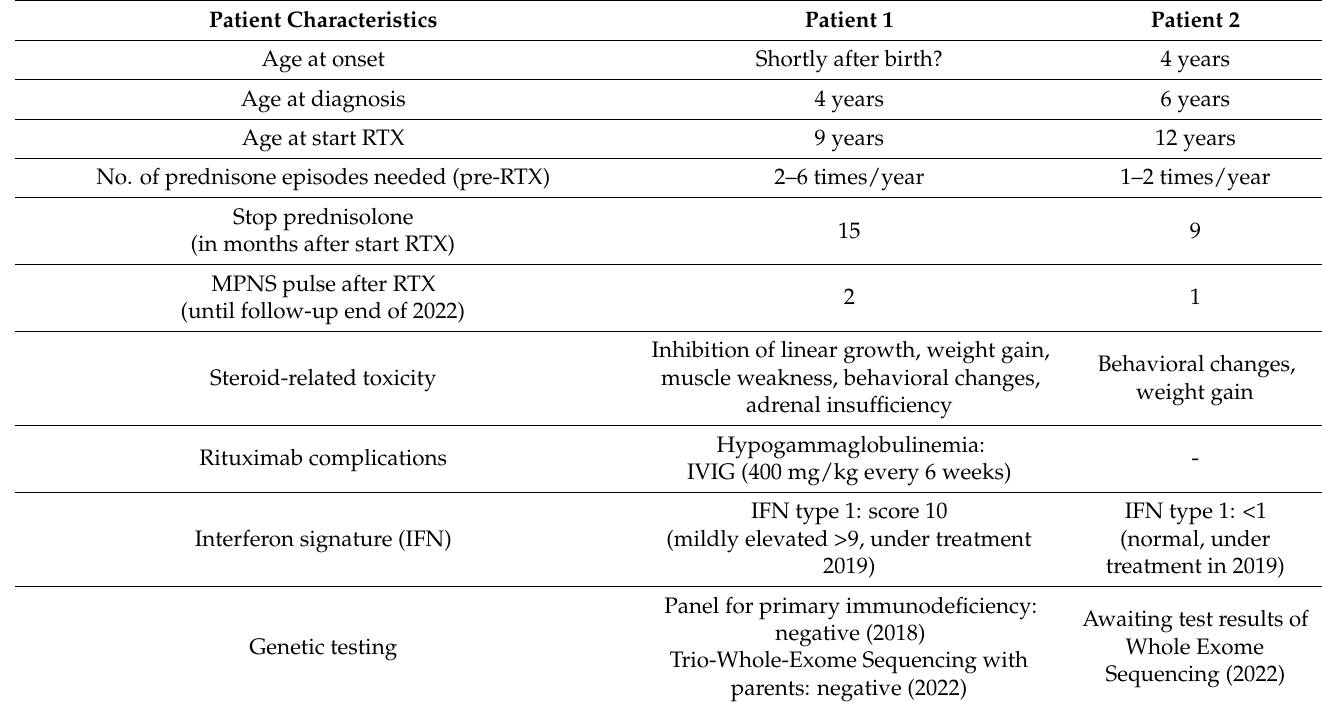
Table 1. Patient characteristics, disease course, and treatment of 2 patients with idiopathic pulmonary hemorrhage. RTX, rituximab; MPNS, methylprednisolone; IVIG, intravenous